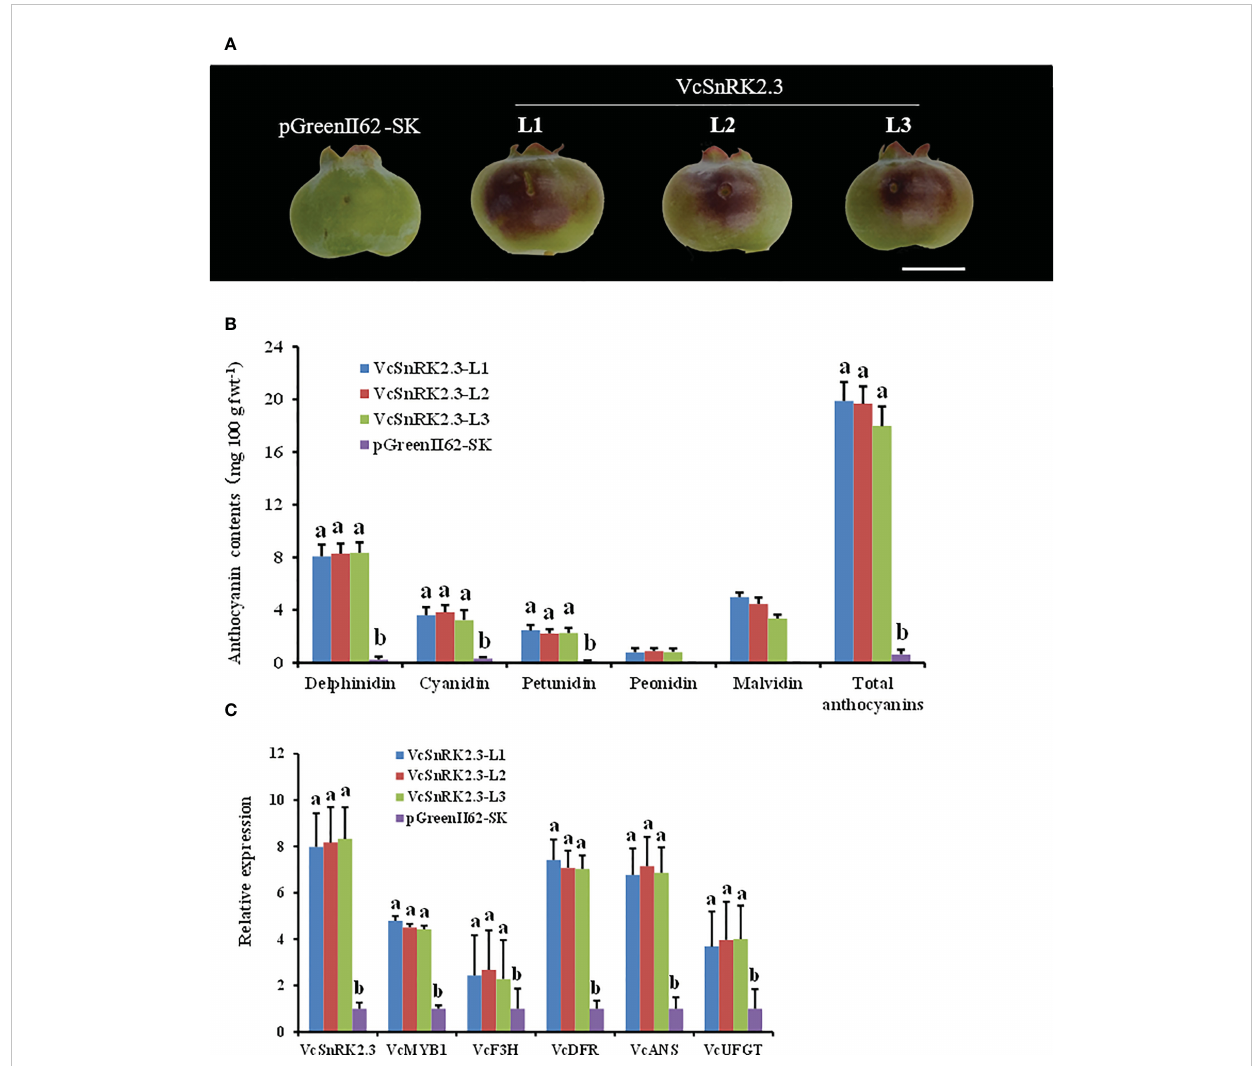
FIGURE 5 Functional analysis of Vc SnRK2.3 in blueberry. (A) Blueberry fruits overexpressing pGreenII62-SK and VcSnRK2.3 -pGreenII62-SK ( VcSnRK2.3 -L1, L2 and L3). Scale bar = 5 mm. (B) Anthocyanin contents of fruits overexpressing VcSnRK2.3 -pGreenII62-SK ( VcSnRK2.3 -L1, L2 and L3) and pGreenII62- SK. Different English letters above the bars indicate a signi fi cant difference based on a t-test ( P < 0.05). Values are the means + SD of three biological replicates. (C) Relative expression levels of VcSnRK2.3, VcMYB1, VcF3H, VcDFR, VcANS and VcUFGT in overexpressed VcSnRK2.3 -pGreenII62-SK ( VcSnRK2.3 -L1, L2 and L3) and pGreenII62 -SK fruits. The qRT-PCR served as a reference gene with VcGAPDH . Different letters above the bars indicate a signi fi cant difference based on a t-test ( P < 0.05). Values are the means + SD of three biological